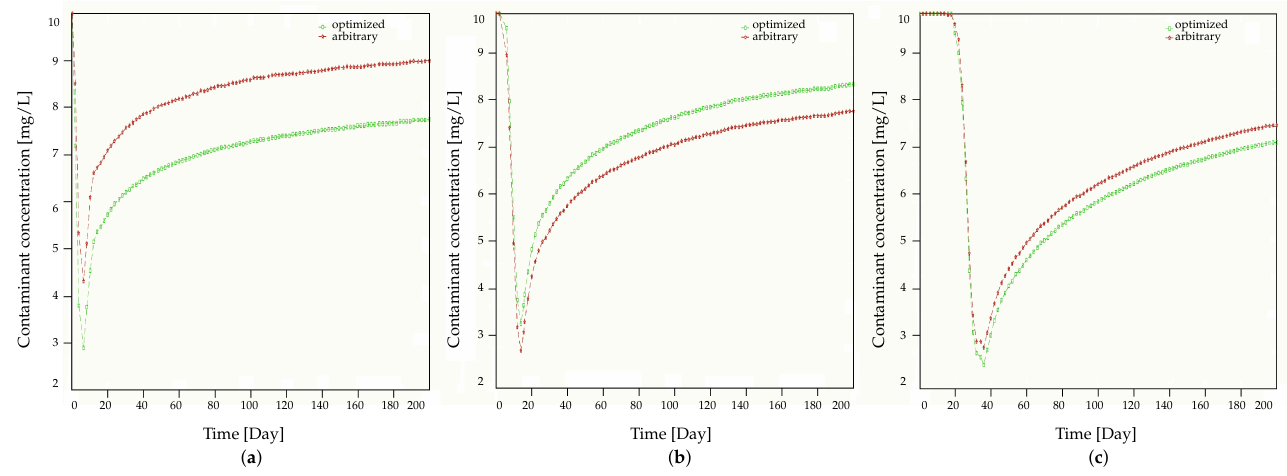
Figure 8. ( a ) piezometric head profile and contours, ( b ) contaminant concentration profile, ( c ) oxidant concentration profile.